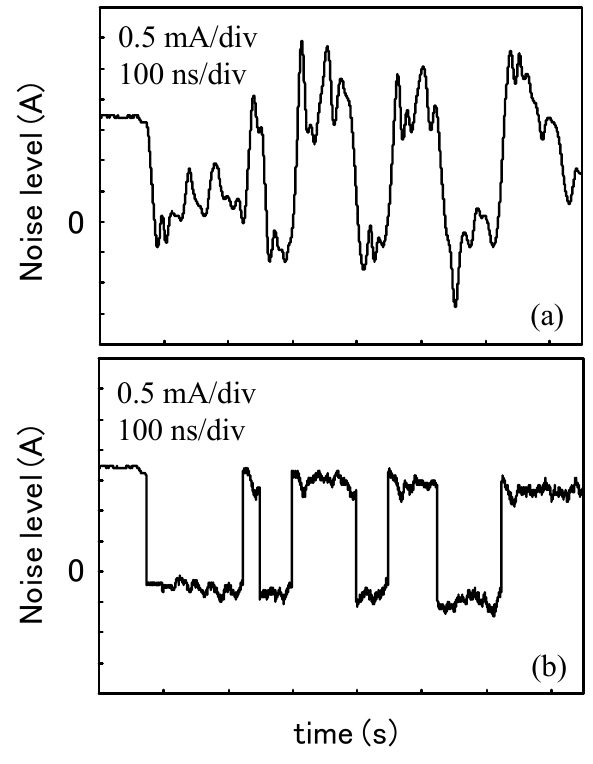
Figure 9. Common-mode noise waveforms for 800 × 600 pixels monitor specification: ( a ) before processing, ( b ) after processing.